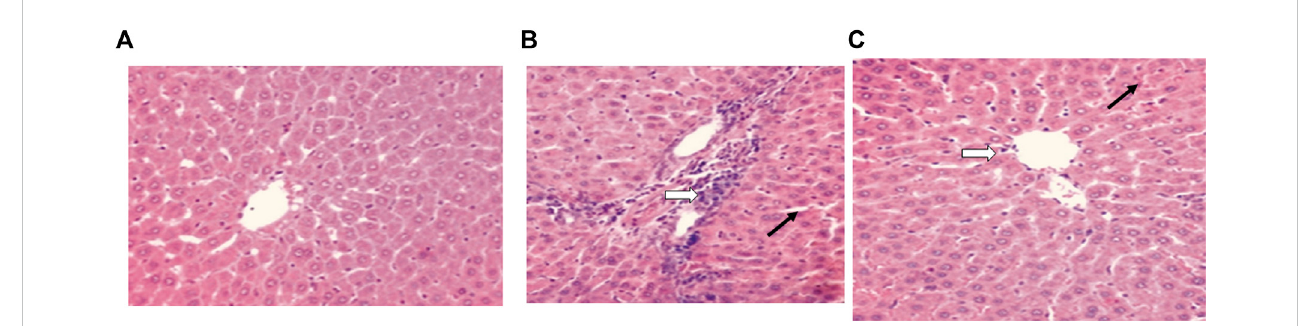
FIGURE 4 Histopathological liver evaluation in (A) control rats, (B) rats injected with vancomycin only, liver-Intralobular mononuclear in fl ammatory in fi ltrations (white arrow), and Mallory bodies (black arrow) due to degeneration of hepatocytes and increased vacuolation in the cytoplasm of hepatocytes appeared as indistinctclearvacuoles(blackarrow)indicateglycogenin fi ltrationand (C) ratsinjectedwithvancomycinandresveratrol,liver-showedmarkedimprovedona mononuclear cell, and decrease number of mononuclear in fl ammatory in fi ltrates (white arrow) and decrease of Mallory bodies (black